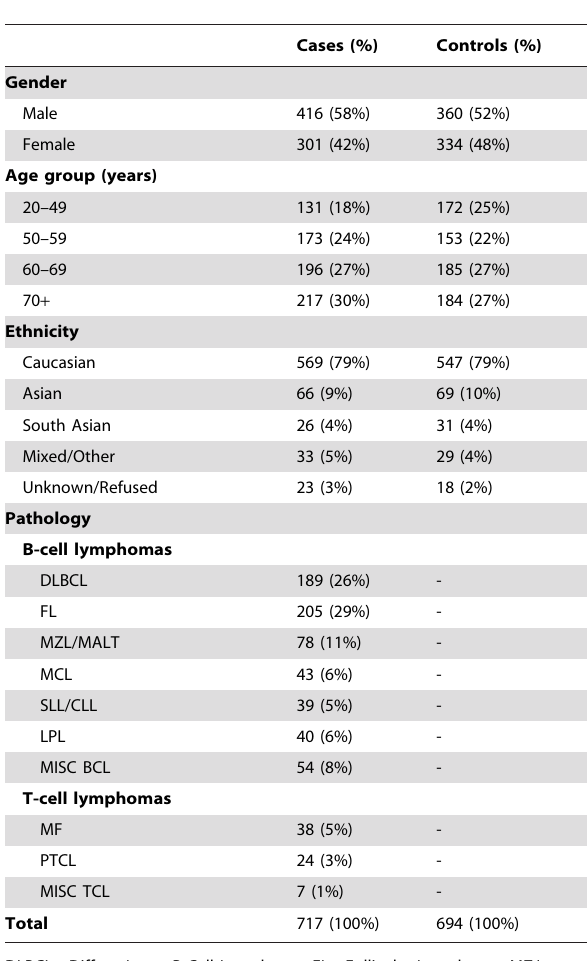
Table 1. Characteristics of samples used in genetic association